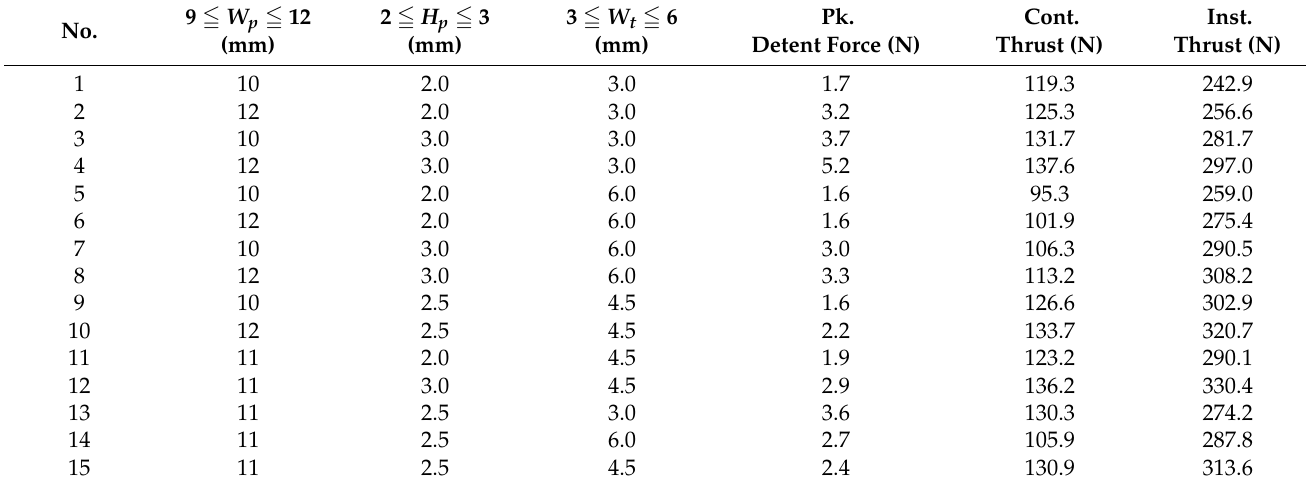
Table 3. CCD arrays and corresponding FEA values.